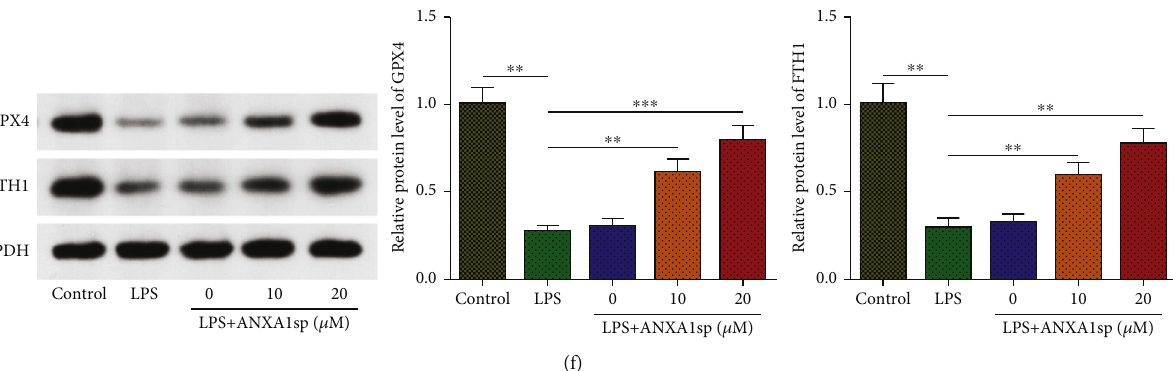
Figure 2: ANXA1sp inhibits LPS-caused oxidative stress and ferroptosis in H9C2 cardiomyocytes. H9C2 cells were assigned to control, LPS, and LPS+ANXA1sp groups. (a – d) ROS, MDA, SOD, and GSH levels in H9C2 cell supernatant. (e) Iron accumulation in H9C2 cells. (f) WB for levels of ferroptosis-related proteins (GPX4 and FTH1) in H9C2 cells. The experiments were repeated three times ( n = 3 ). Data were presented as mean ± SD . All statistical analyses were performed using Student ’ s t -test or one-way ANOVA. ∗ p < 0 : 05 ; ∗∗ p < 0 : 01 ; ∗∗∗ p < 0 : 001